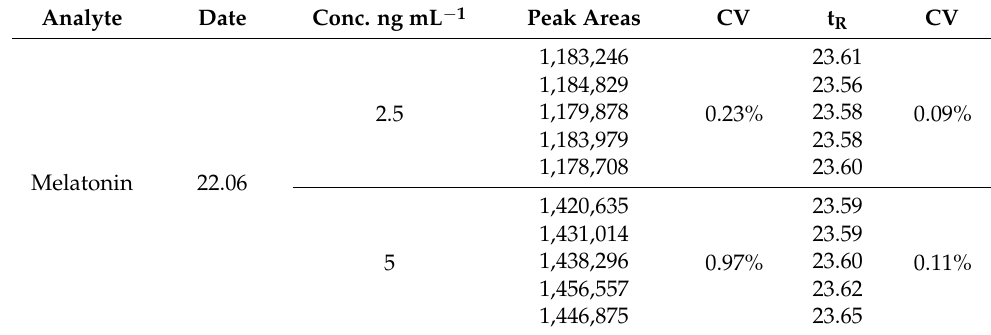
Table 2. The experimental results obtained to demonstrate the repeatability of the HPLC-FL